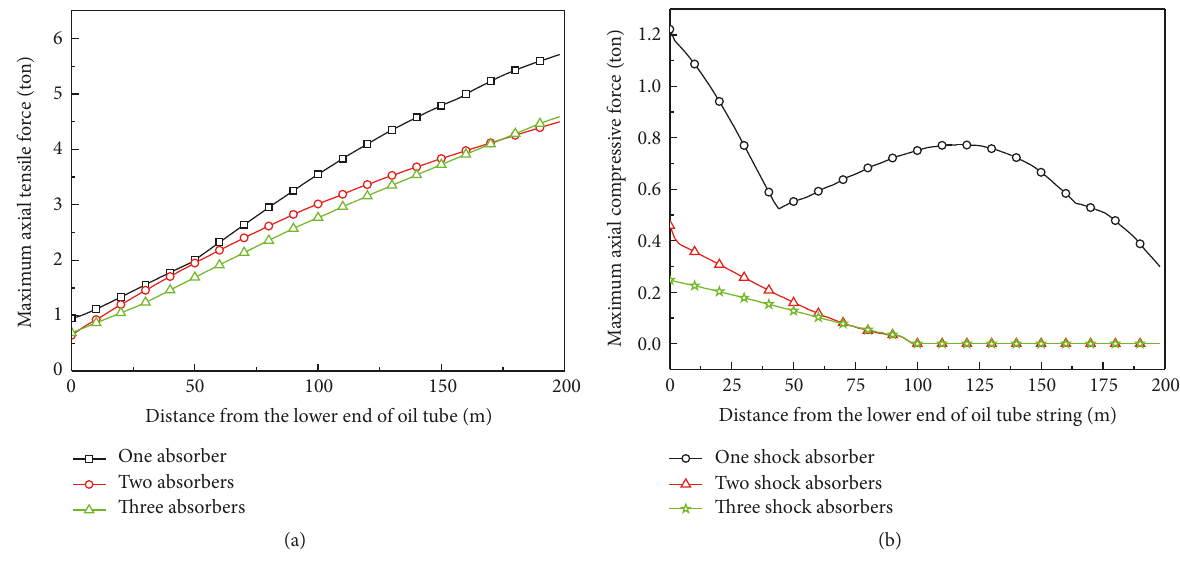
Figure 13: Effect of shock absorber on the maximum dynamic axial force in oil tube string: (a) tensile force; (b) compressive force.